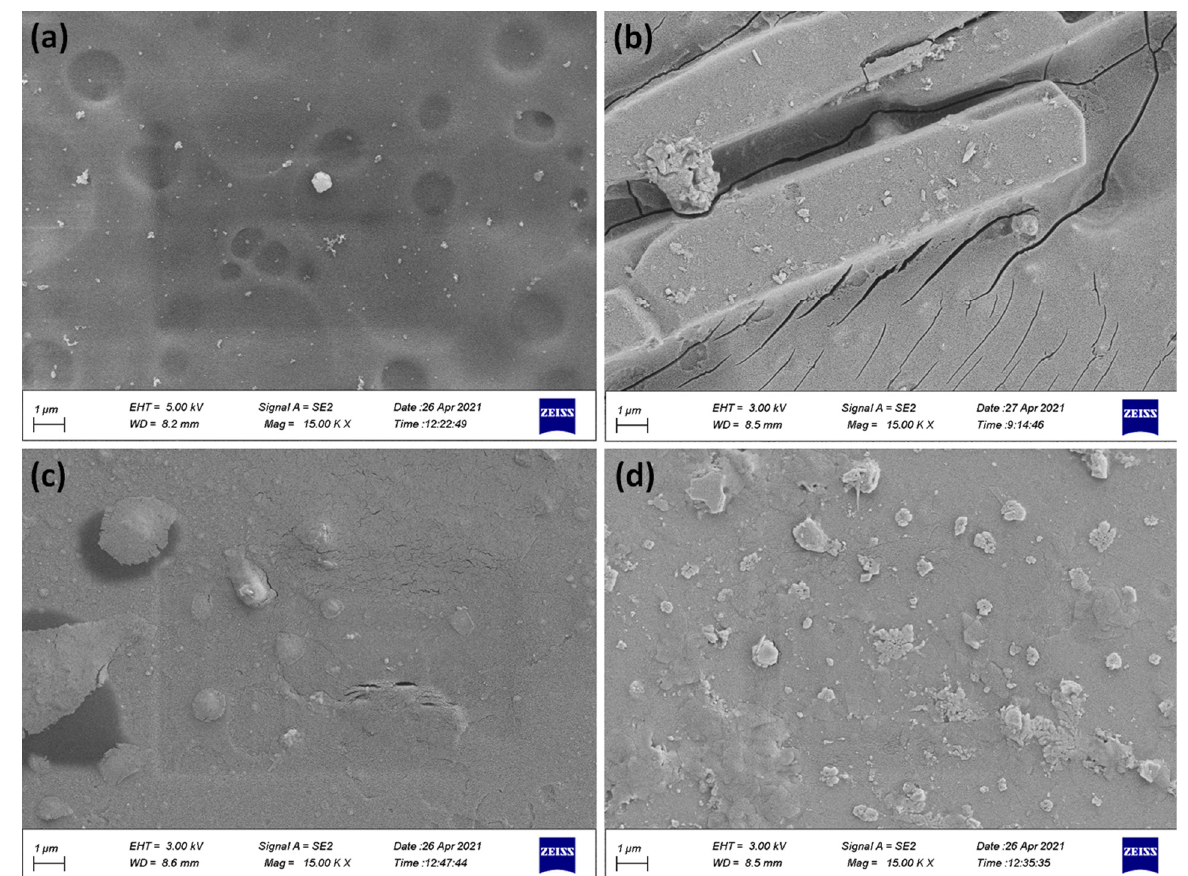
Figure 6. FESEM images of ( a ) PVC, ( b ) PVC + 1 , ( c ) PVC + 2 and ( d ) PVC + 3 films after irradiation.